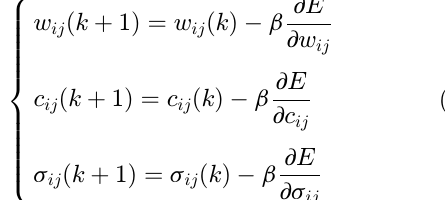
optimization algorithm is used to adjust uncertain